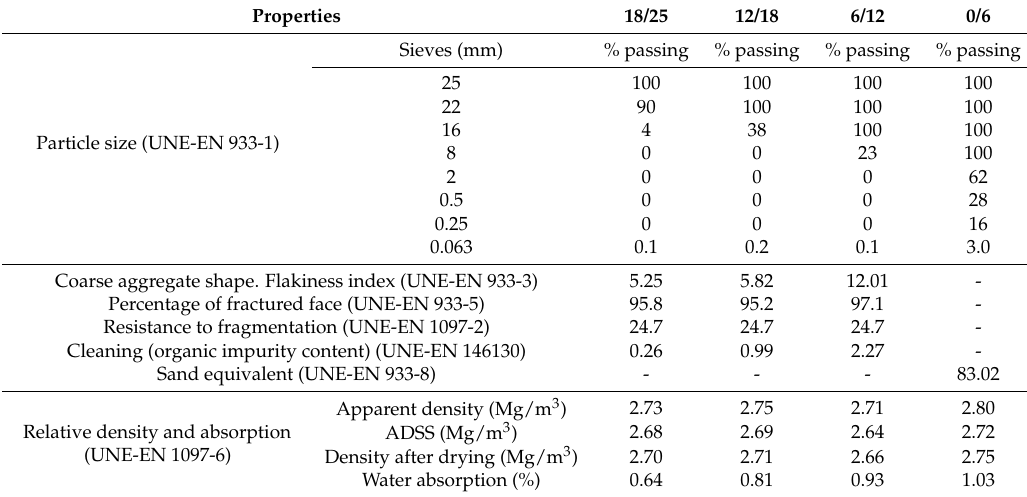
Table 1. Aggregates properties.